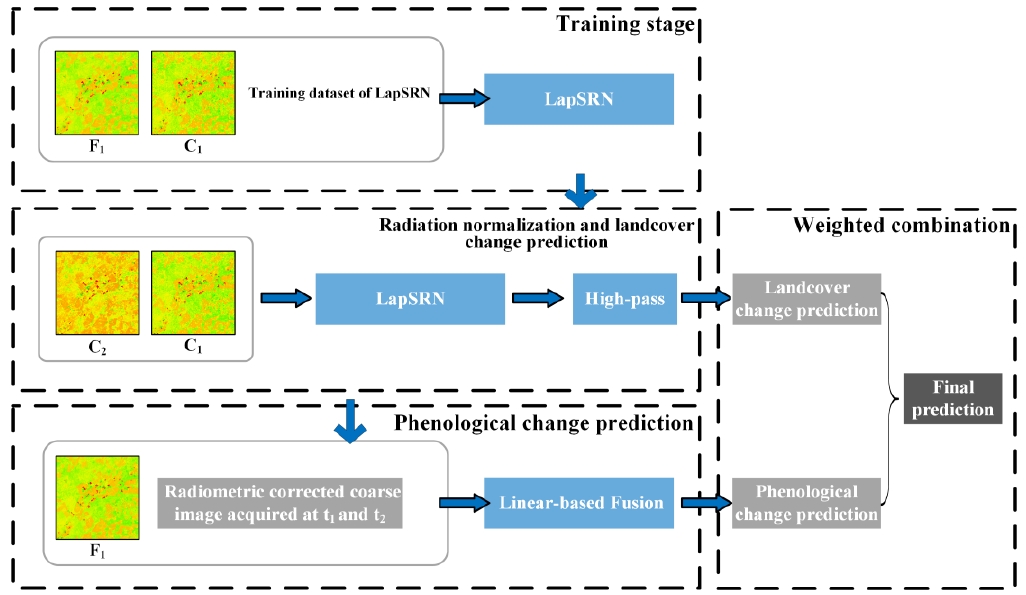
Figure 1. Flowchart of the hybrid deep learning (DL)-based spatiotemporal fusion method (HDLSFM).